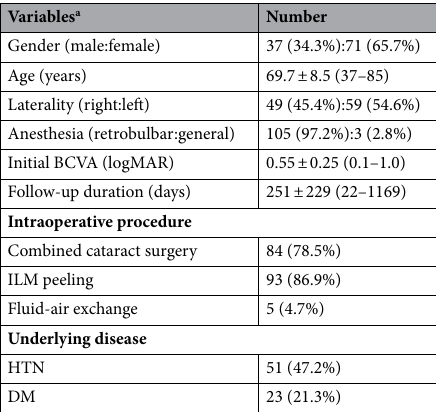
Table 1. Baseline patient characteristics. SD standard deviation, logMAR logarithm of the minimum angle of resolution, BCVA best corrected visual acuity, ILM internal limiting membrane, HTN hypertension, DM diabetes mellitus. a Eyes of a patient who received epiretinal membrane surgery on both eyes were counted separately as twice in the baseline demographics